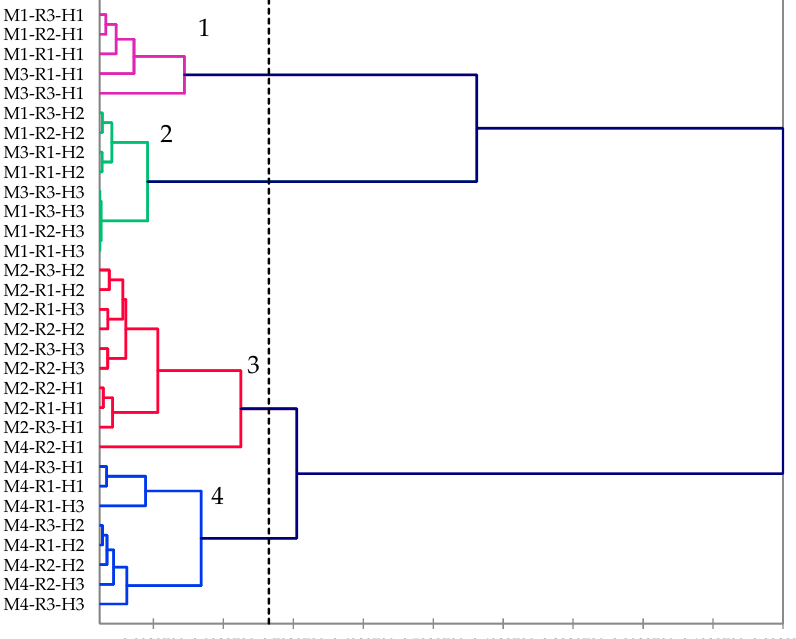
Figure 3. Dendrogram obtained by hierarchical cluster analysis of the 16 most abundant components of Pycnanthemum virginianum essential oils. ‘M’ represents the varieties, ‘R’ is the replicate of each variety, and ‘H’ is the harvesting times.